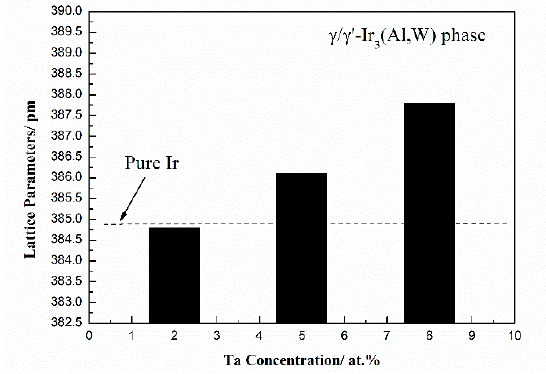
Figure 1. X-ray di ff raction patterns of as-cast Ir-based alloys: ( a ) Ir–6Al–13W alloy; ( b ) Ir–6Al–13W–xTa alloys.